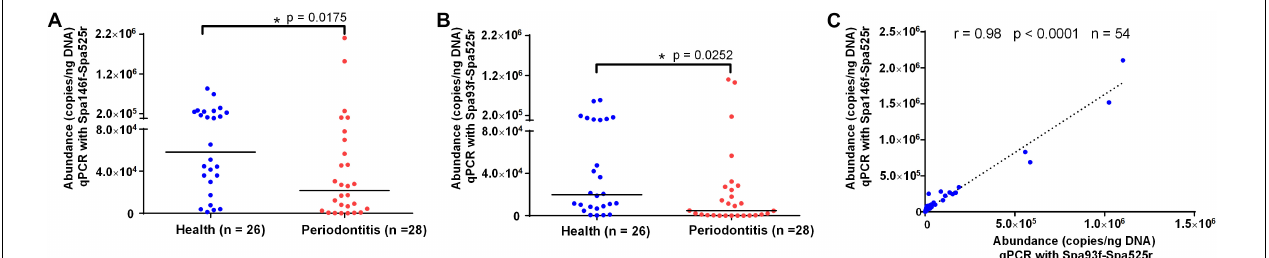
FIGURE 5 | The saliva S. parasanguinis concentrations determined by qPCR with two primer pairs in periodontitis patients and periodontally healthy people. (A) The saliva S. parasanguinis abundance quantified with Spa146f-Spa525r in oral health and periodontitis. (B) The saliva S. parasanguinis abundance quantified with Spa93f-Spa525r in oral health and periodontitis. The line among the dots represents the median. The values were compared between two groups using the Mann–Whitney U test. (C) Pearson’s correlation of the human saliva S. parasanguinis concentrations determined by qPCR with two primer pairs, Spa146f-Spa525r and Spa93f-Spa525r. The correlation coefficient ( r ), p -value, and the number of fecal samples ( n ) are shown.